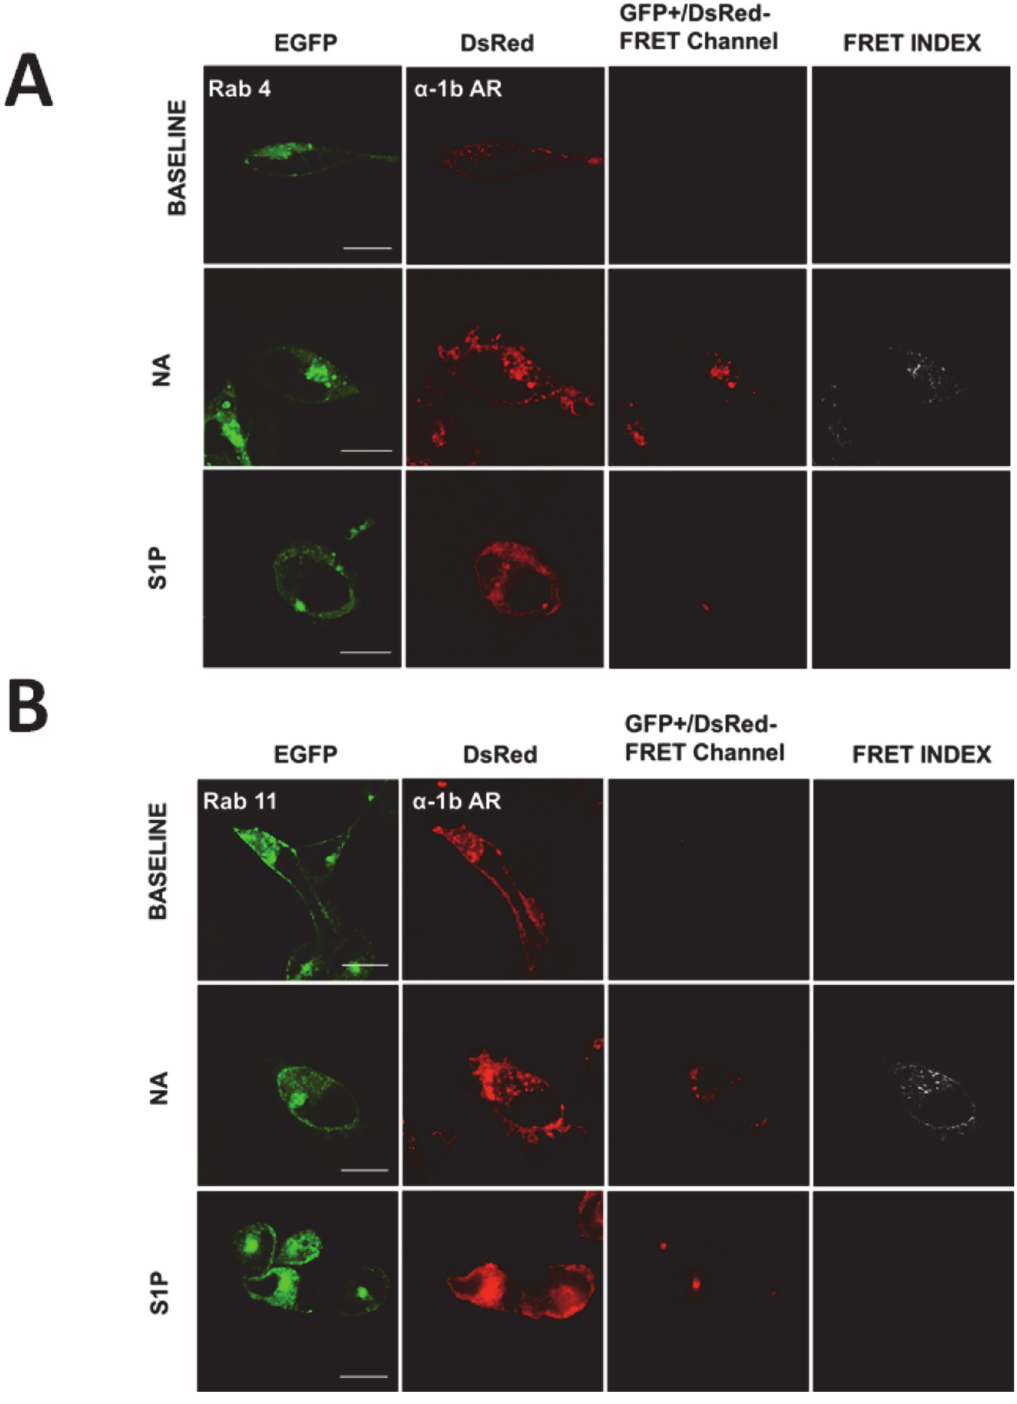
Fig 6. α 1B -Adrenergic receptor-Rab 4 and Rab 11 interactions. Images of cells coexpressing α 1B -adrenergic receptors tagged with the DsRed fluorescent protein ( α 1B -AR) and Rab 4 (panel A) or Rab 11 (panel B) tagged with the enhanced green fluorescent protein (EGFP). Scale bars: 15 μ m.Other indications as in Fig. 1.